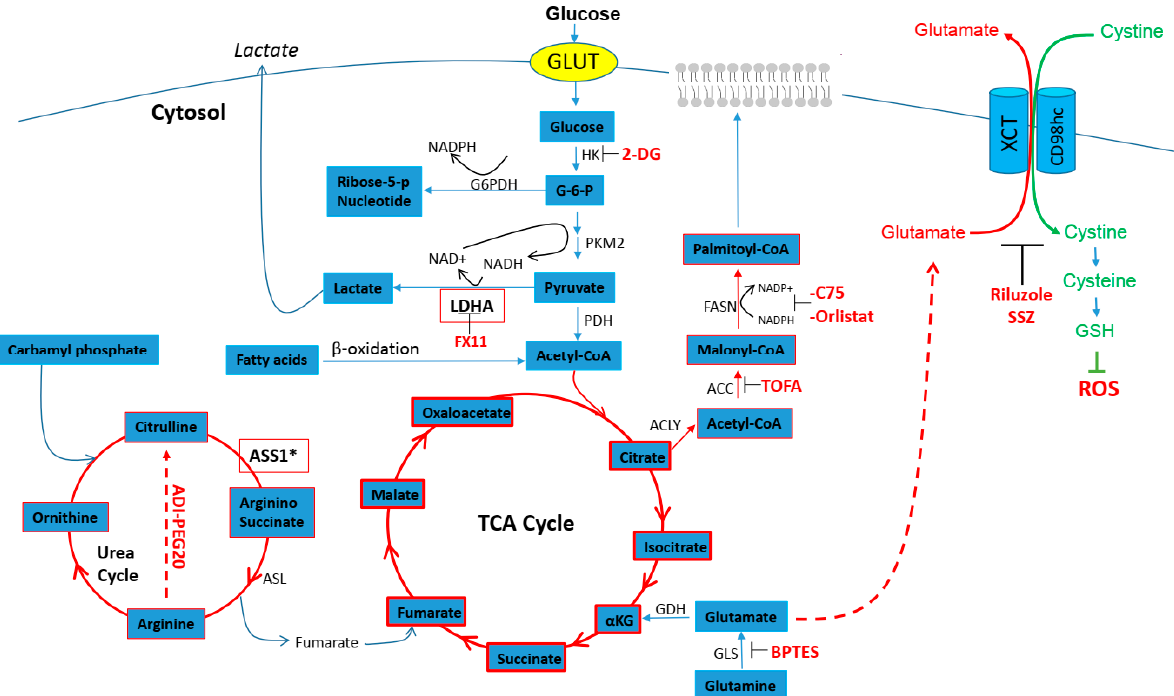
Figure 2. Metabolic scheme of bioenergetics and anabolic metabolism in cancer cells that represent treatment targets. CR cells take up large amounts of glutamine and use these nutrients to fuel the tricarboxylic acid (TCA) cycle and oxidative phosphorylation (OXPHOS). Glutamine is hydrolyzed to glutamate for glutathione synthesis, an essential factor to abrogate high ROS via xCT antiporter. Increased fatty acid synthesis enzymes are also found in CR tumors. Moreover, tumors lacking ASS1 enzyme in the urea cycle require extracellular arginine in the circulation for survival. ACLY = ATP citrate lyase, ACC = acetyl-CoA carboxylase, ADI-PEG = arginine deiminase pegylated-20, ASL = argininosuccinate lyase, ASS1 = argininosuccinate synthetase, BPTES = glutaminase inhibitor, CD98hc = CD98 heavy chain, 2-DG = 2-deoxy-d-glucose, FX= LDHA inhibitor, FASN = fatty acid synthase, G-6-P = glucose-6-phosphate, G6PDH = glucose-6-P dehydrogenase, GLS = glutaminase, GDH = glutamate dehydrogenase, GLUT = glucose transporter, GSH = glutathione, HK = hexokinase, α -KG = alpha- ketoneglutarate, LDHA = lactate dehydrogenase-A, PDH = pyruvate dehydrogenase, PKM2 = pyruvate kinase isozymes M2, PPP = pentose phosphate pathway. ROS = reactive oxygen species, SSZ = Sulfasalazine, TCA = tricarboxylic acid, XCT = system x c- amino-acid